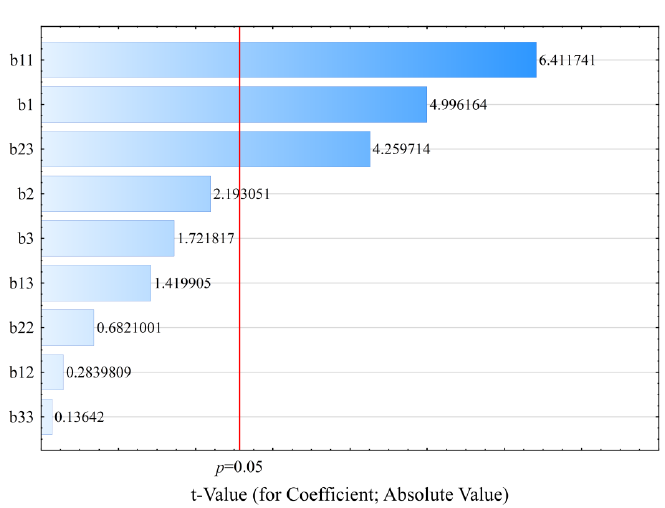
FIGURE 2 - Pareto chart of standardized effects for inhibition zone diameter against Neurospora crassa